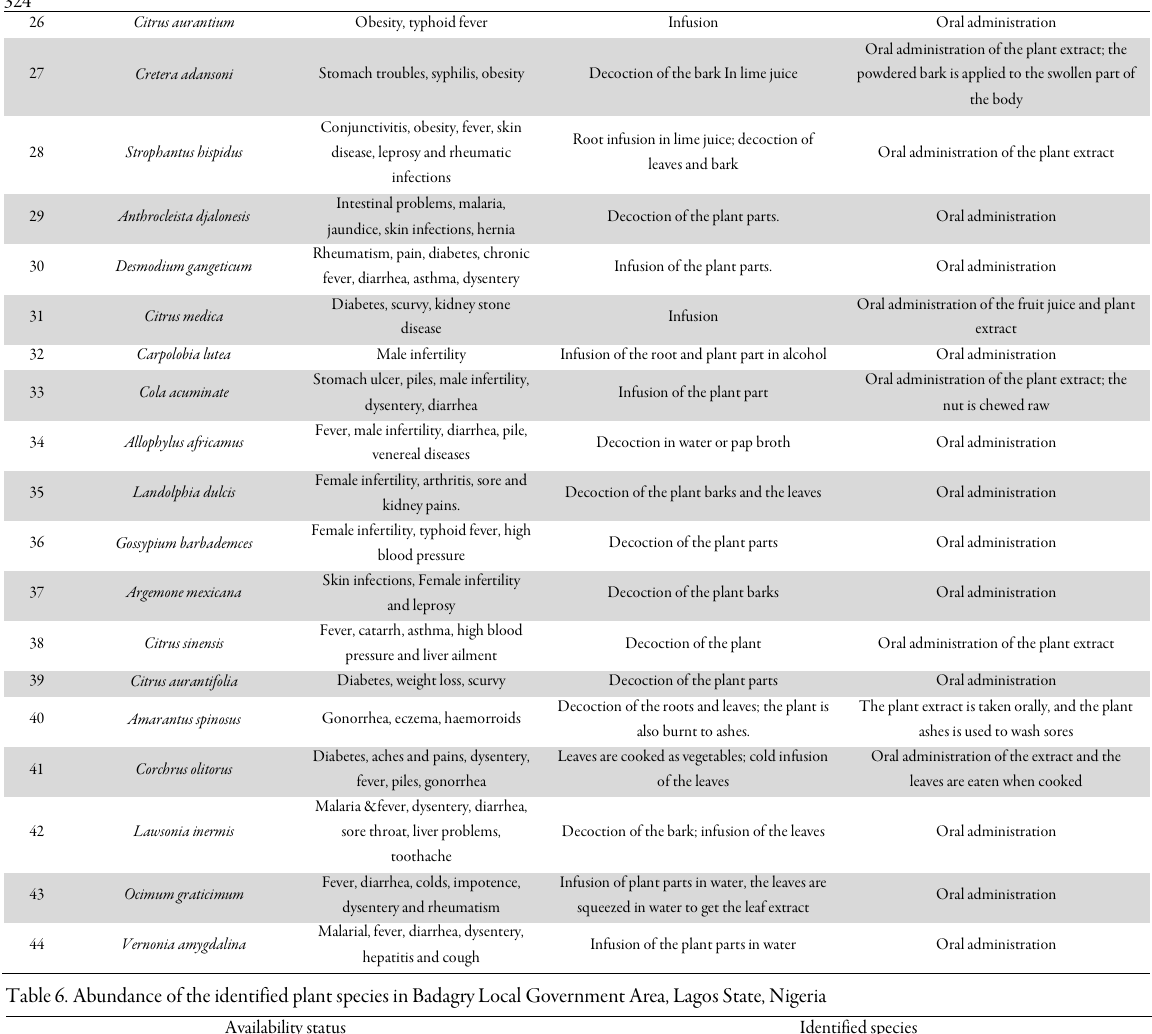
Table 6. Abundance of the identified plant species in Badagry Local Government Area, Lagos State, Nigeria